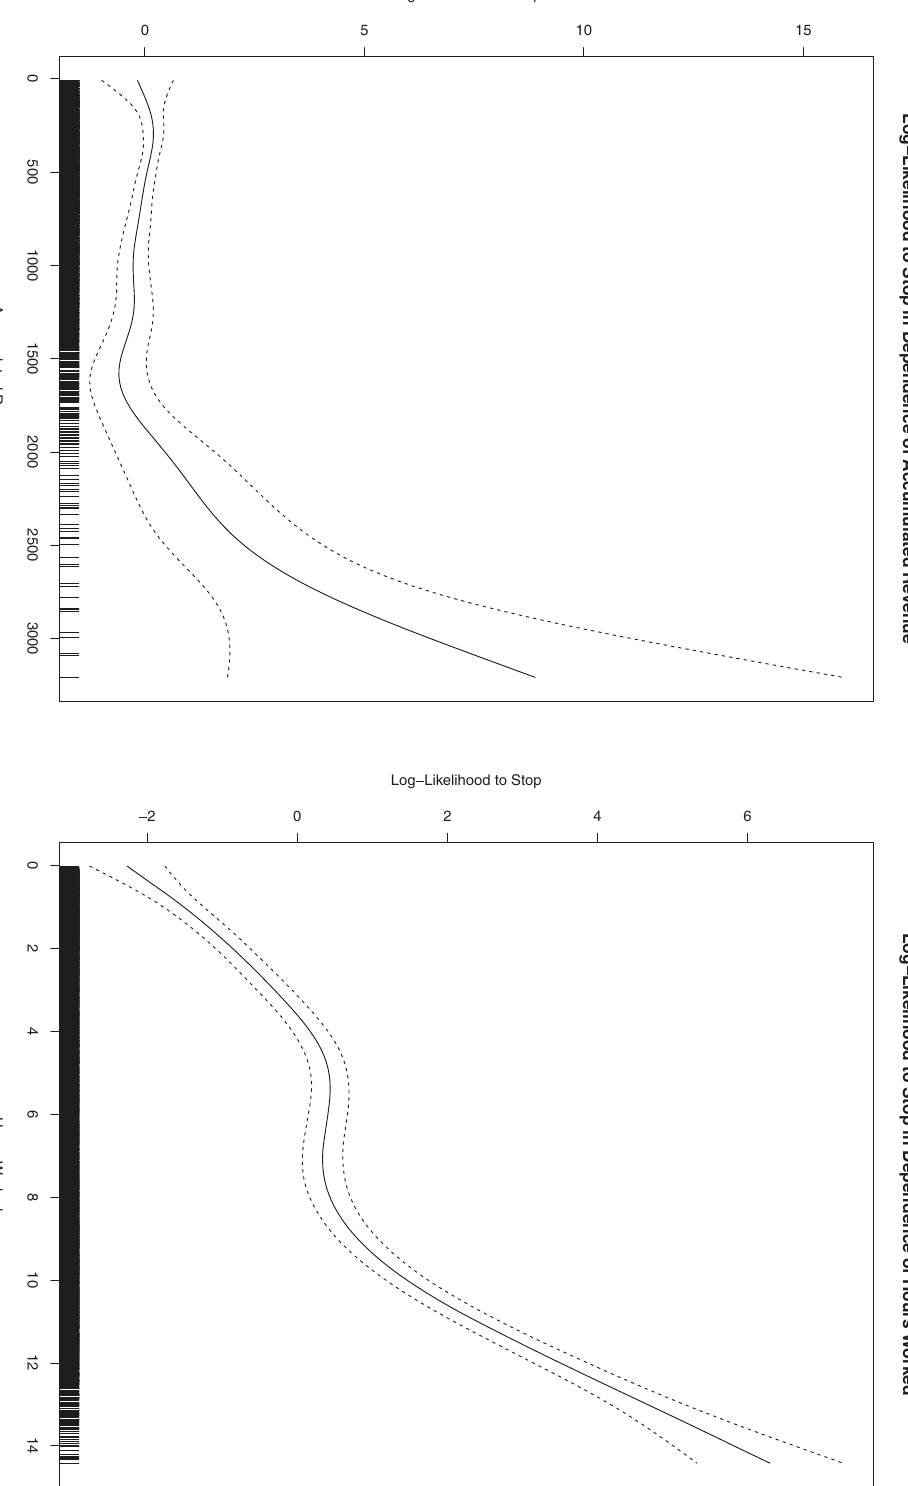
Fig. 1 Line indicating the log-likelihood to stop obtained by a regression with a generalised additive model including all parameters, with the exception of revenues accumulated and hours worked which were chosen as variables to smooth over. No hour fi xed effects were included. 95% con fi dence interval included. Smoothing parameter of 2.47 chosen for accumulated revenues and 5.51 for hours worked. See more particular regression results for smooth terms in Table A.4. Source: Own representation, Data: GoMetro